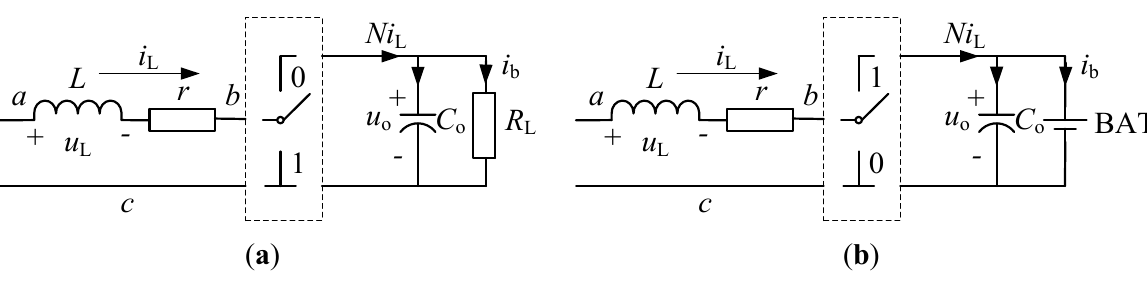
Figure 16. Equivalent switching network of BSS-FBC: ( a ) Charging mode; ( b ) Discharging mode.